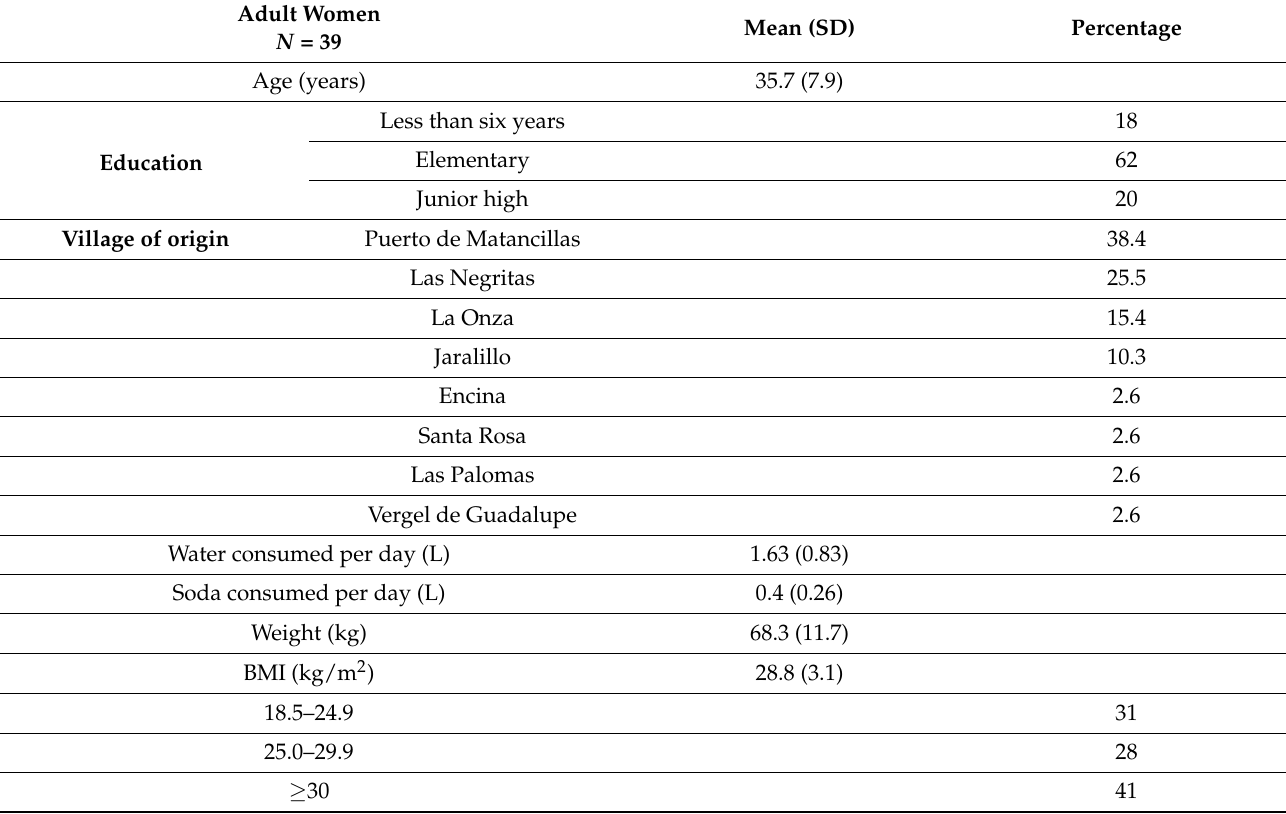
Table 1. General characteristics of the studied women and children from the High Basin of the Laja River. Adult